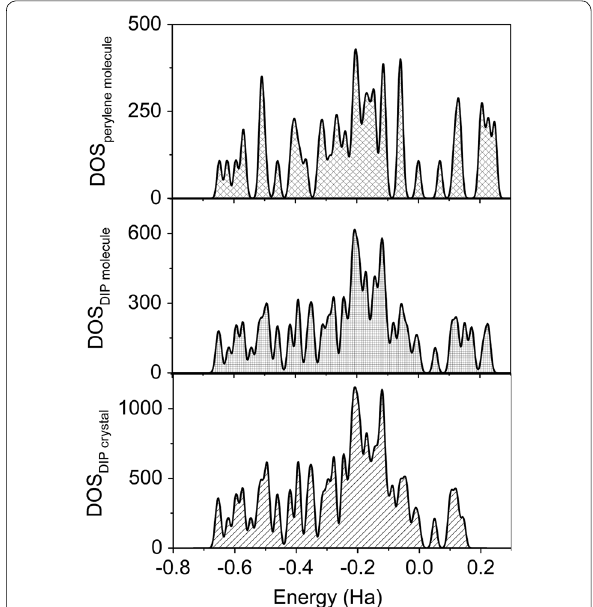
Fig. 4 Computed density of states (DOS) of perylene molecule, DIP molecule and DIP molecular